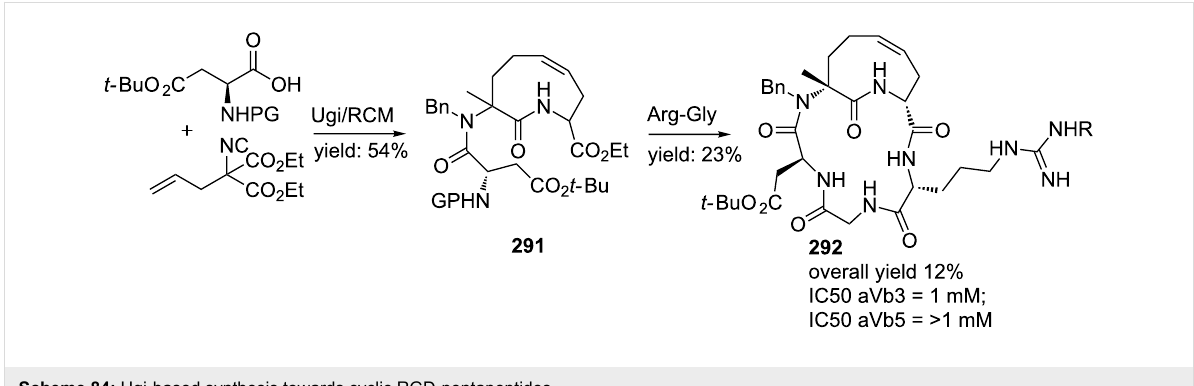
Scheme 84: Ugi-based synthesis towards cyclic